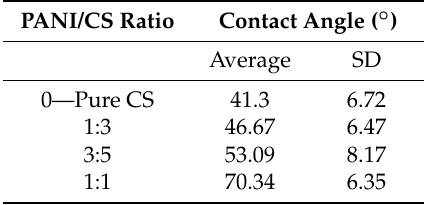
Table 2. Contact angle measurements for electrospun PANI/CS membranes after